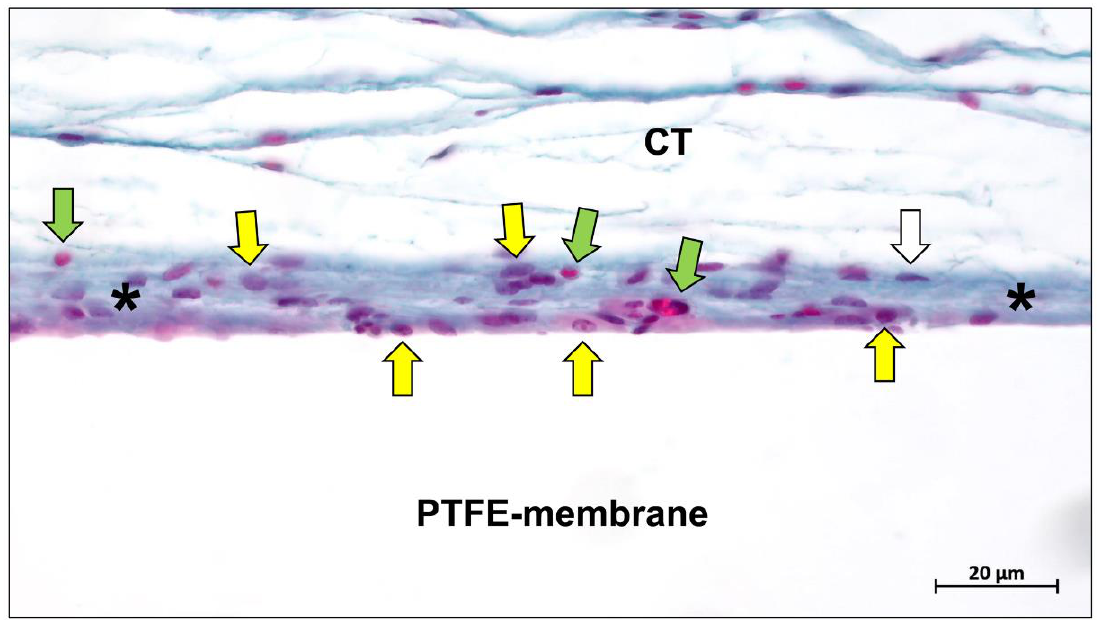
Figure 1. Representative histological image showing the tissue reaction to a subcutaneously im- planted PTFE membrane at day 30 post implantationem. Asterisks = thin reactive tissue wall, yellow arrows = macrophages, green arrows = eosinophils, white arrow = fibroblast, CT = connective tissue (Alcian blue staining, 400× magnification, scalebar = 20 µm).